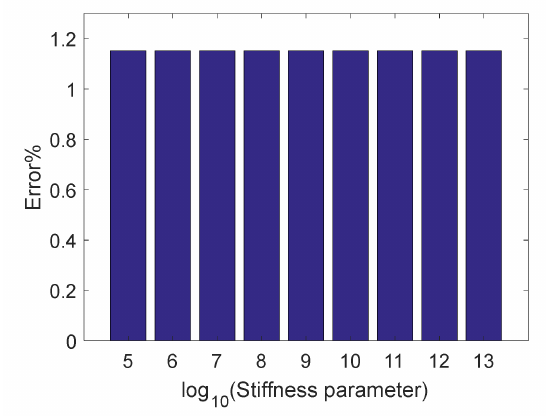
. ( − ) = 0.2 m/s, c r = 0.9). δ